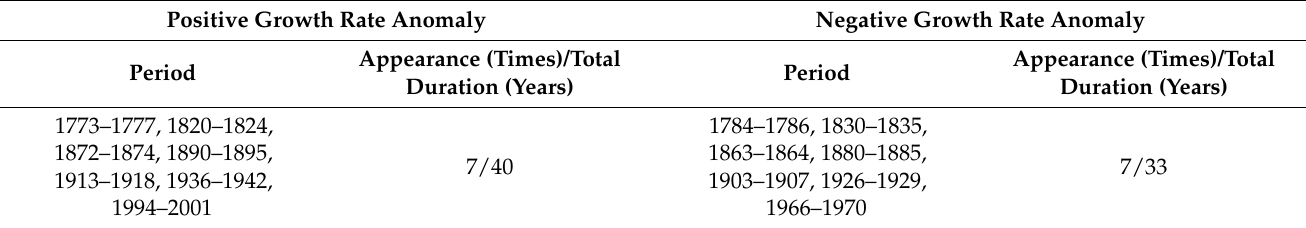
Table 2. Summary of the positive and negative growth rate